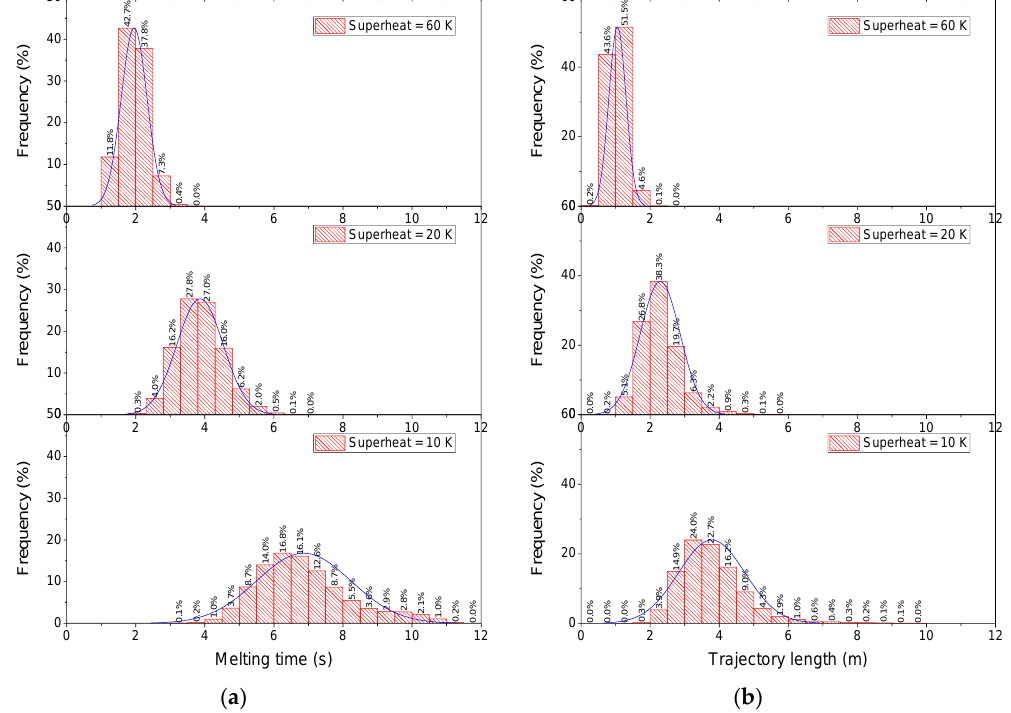
Figure 9. Melting time and trajectory length of aluminum particles under different superheats: ( a ) Melting time; ( b ) trajectory length.